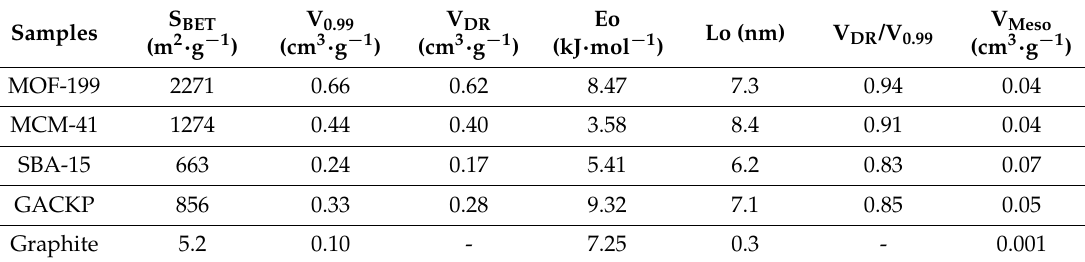
Table 1. Textural parameters of all samples from the N 2 adsorption-desorption isotherm at − 196 ◦ C. Samples